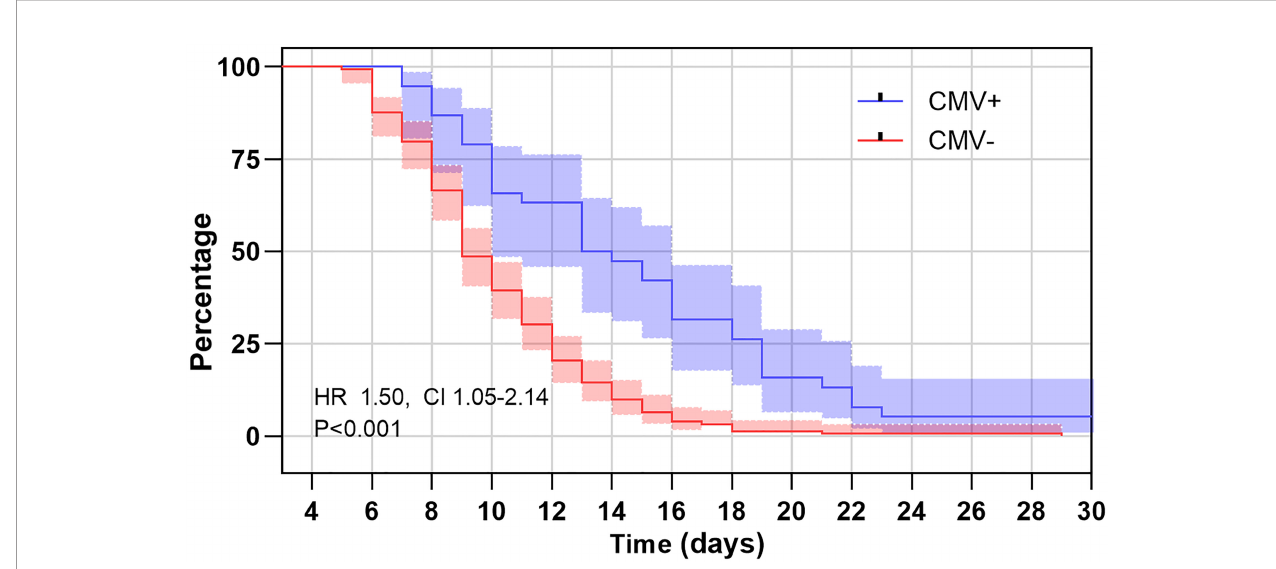
FIGURE 3 | Kaplan – Meier estimates of length of hospital stay for B. pertussis patients with positive cytomegalovirus (CMV) PCR in plasma and those with negative CMV PCR. The log rank test for trend showed signi fi cant association between those with positive CMV PCR and negative CMV PCR (P <